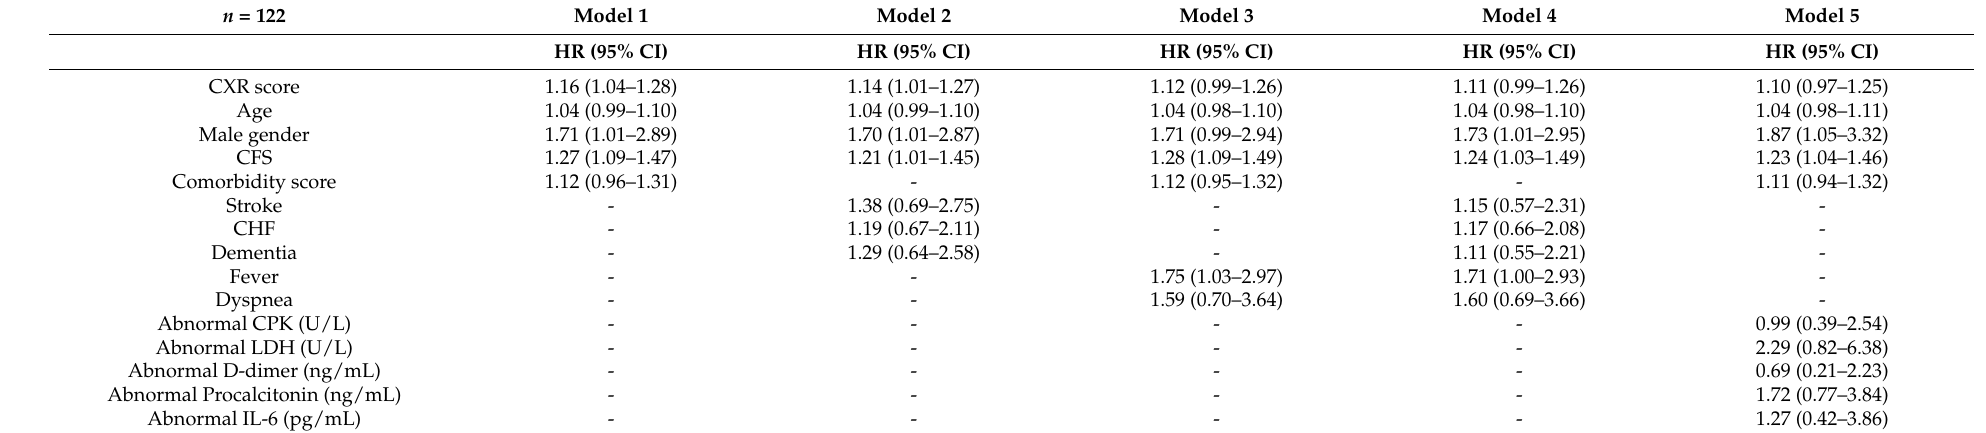
Table 2. Cox proportional hazards models for CXR, CFS, clinical, and laboratory data for death during